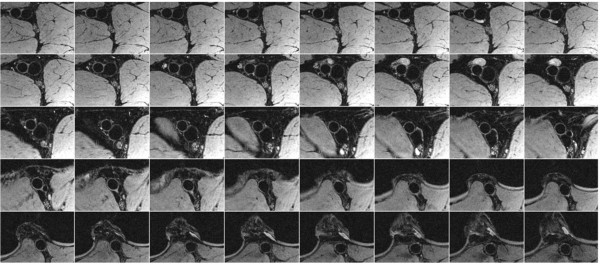
Vessel-wall images of femoropopliteal artery and vein of a healthy 26 year-old subject. Forty contiguous slices are shown in superior to inferior direction (left to right from the top left panel) direction. Larger transmural pressure of artery maintains circular cross section throughout the slices distinguishing artery from adjacent vein. We note that the blood signal suppression level is the same in artery and vein even though the velocity waveforms are quite different.